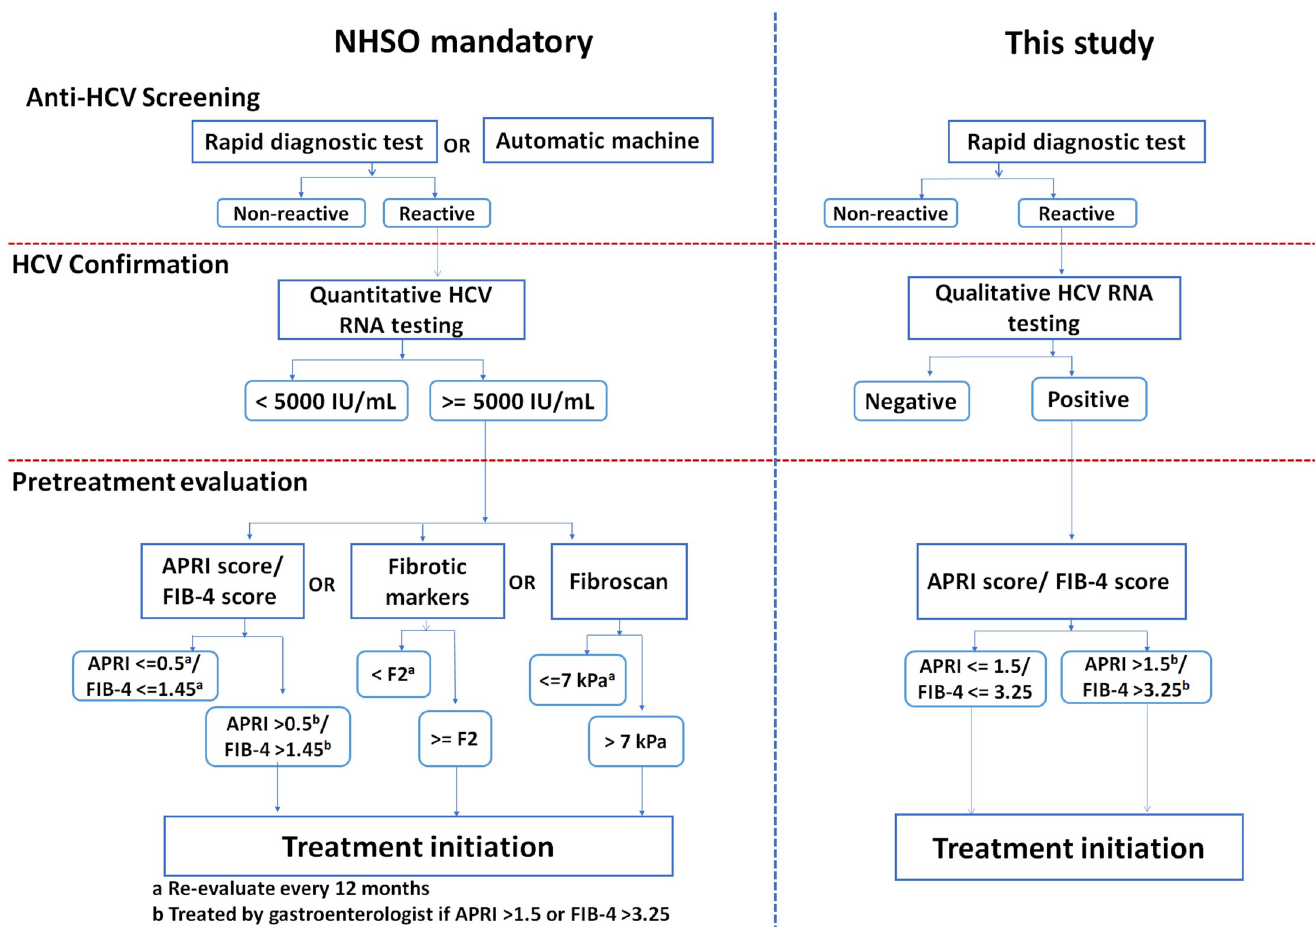
Fig 1. Comparison of implementing a simplified HCV micro-elimination strategy supported by data from this study versus that of the National Health Security Office (NHSO). Comparative anti-HCV screening, HCV confirmation and pretreatment evaluation for cirrhosis are shown.